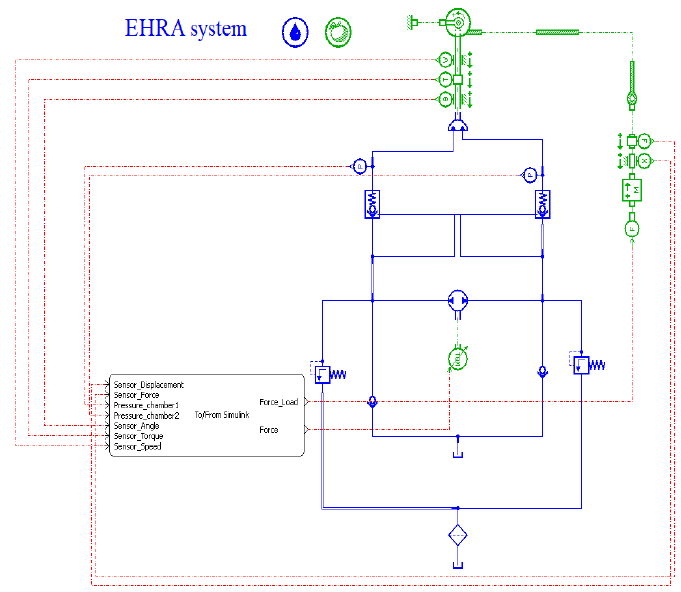
Figure 7. The dynamic EHRA system in AMESim software.